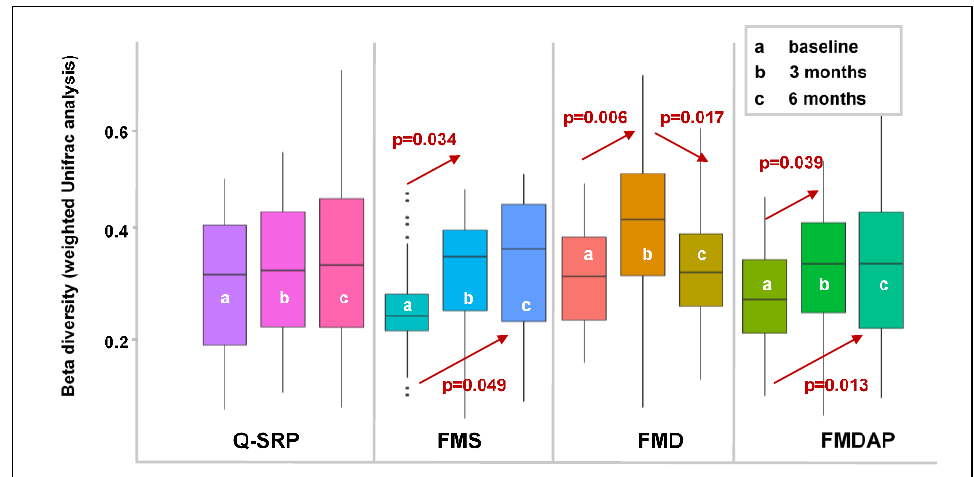
Figure 3. Variations over time in beta diversity (weighted UniFrac analysis) of patients’ subgingival microbiota considering periodontal treatment (comparing of paired groups by applying Wilcoxon signed-ranks test, corrected for multiple comparisons using the Benjamini–Hochberg false discovery rate of 5%). Q-SRP: quadrant-wise subgingival scaling and root planing (SRP); FMS: full-mouth SRP without the use of antiseptics; FMD: full-mouth SRP within 24 h with disinfection using antiseptic applications; FMDAP: FMD combined with the use of subgingival erythritol